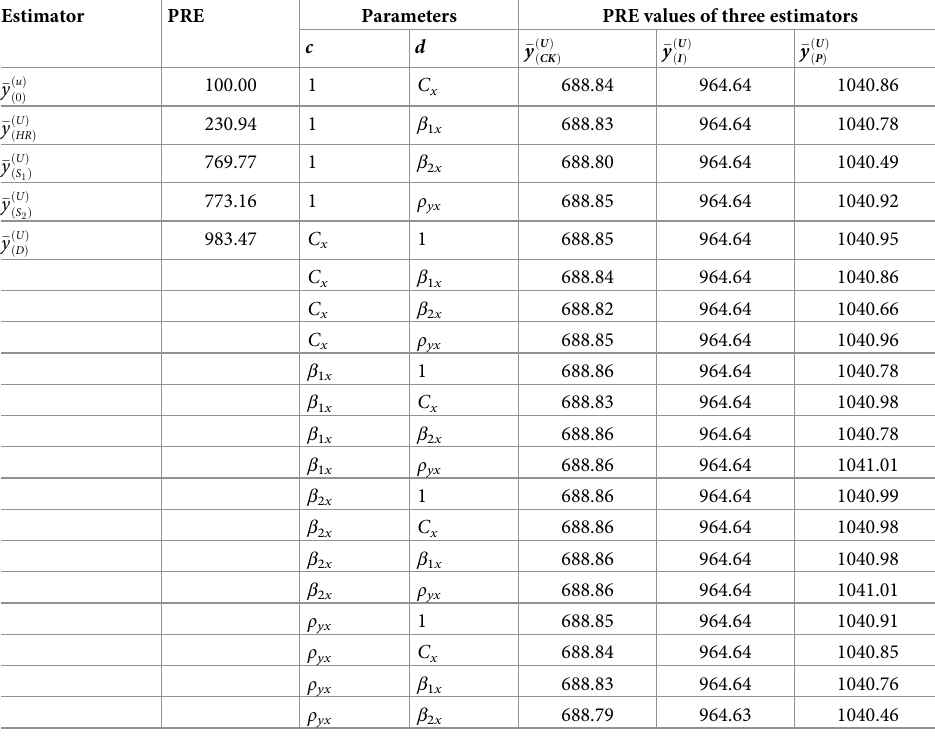
Table 4. Results of different estimators for Population